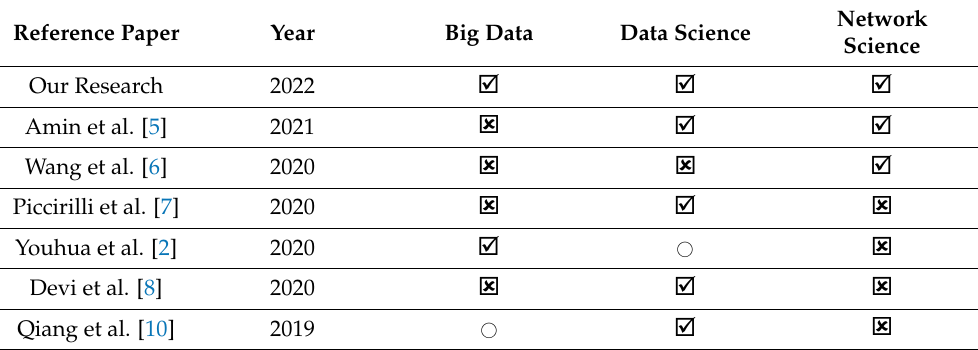
Table 1. Summary and comparison of our survey and current recent research.